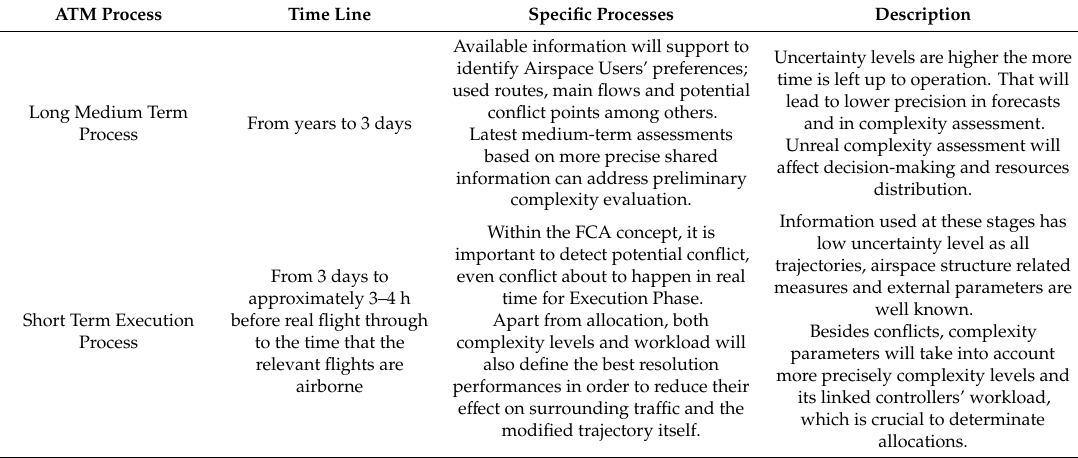
Table 3. Flight centric airspace configuration description in ATM